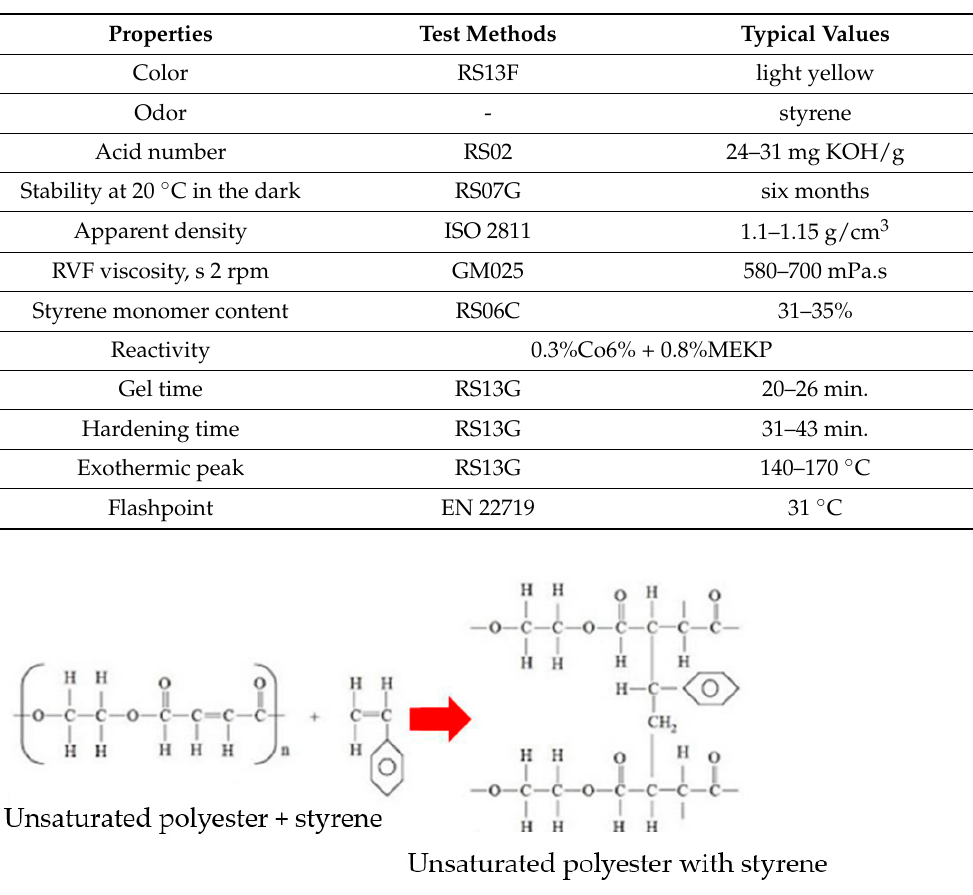
Table 1. Data of the polyester Distitron 5119.